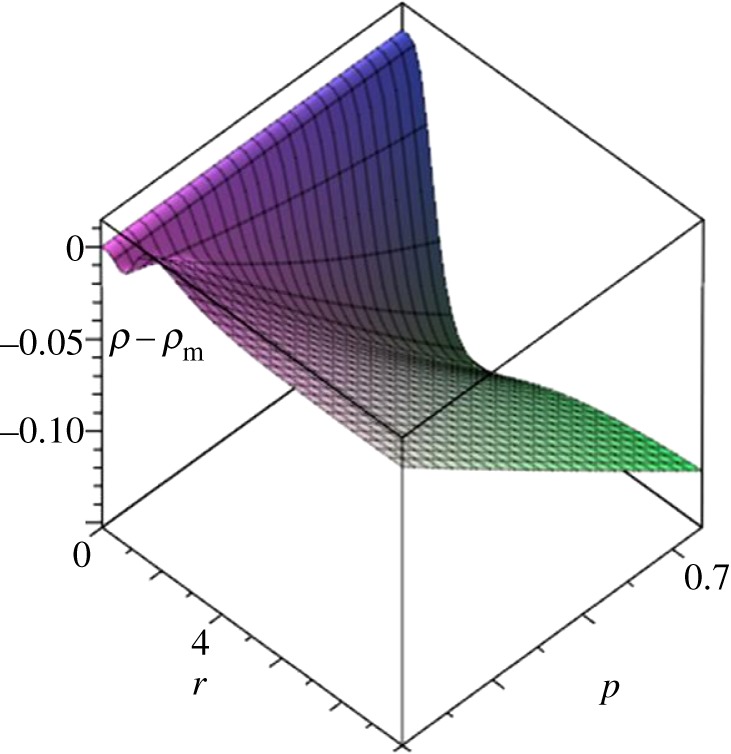
Fixation probabilities for (1,2,3) flow matching temperature profile (2,3/2,1/3).